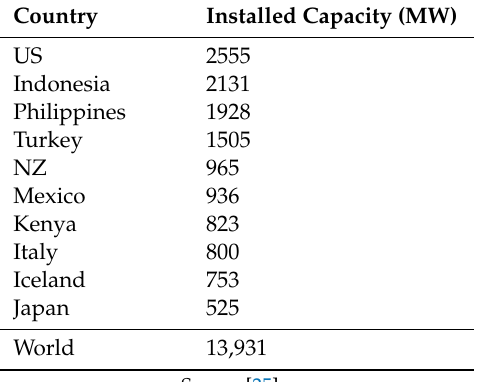
Table 1. Installed 2019 geothermal electric capacity, various countries. Country Installed Capacity (MW) US